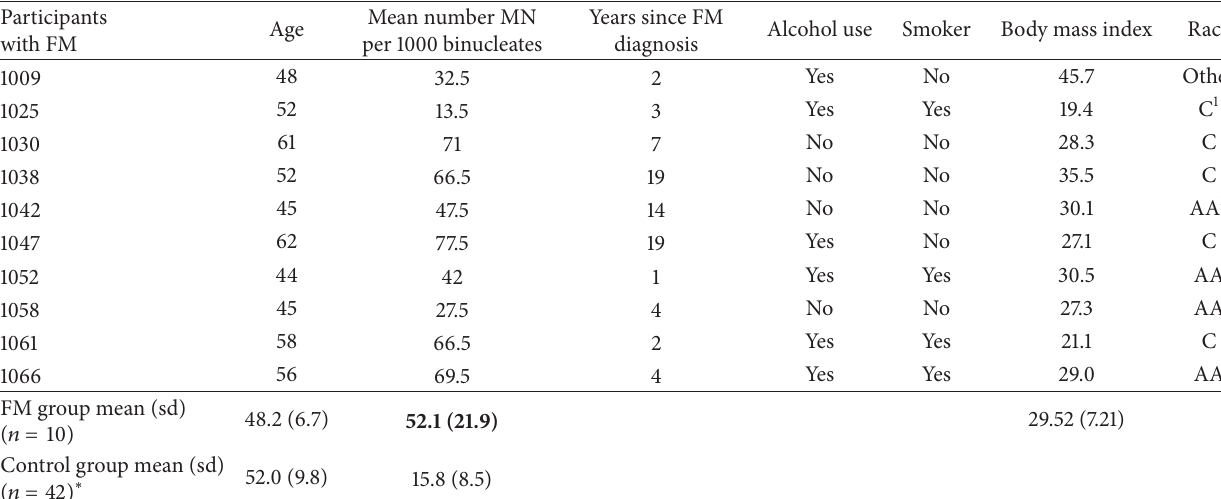
Table 1: MN frequencies and other attributes of women with